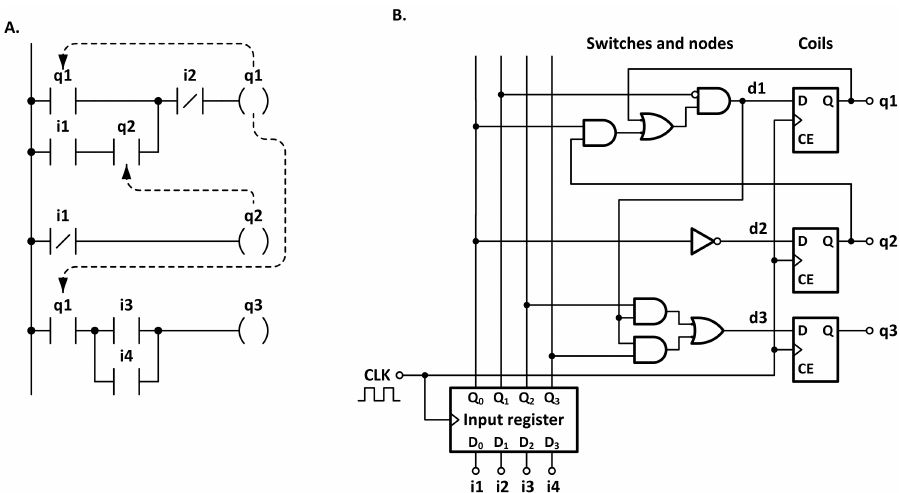
Figure 2. The fast LD translation method illustration: input ladder diagram ( A ) and the equivalent logic circuit implementation ( B